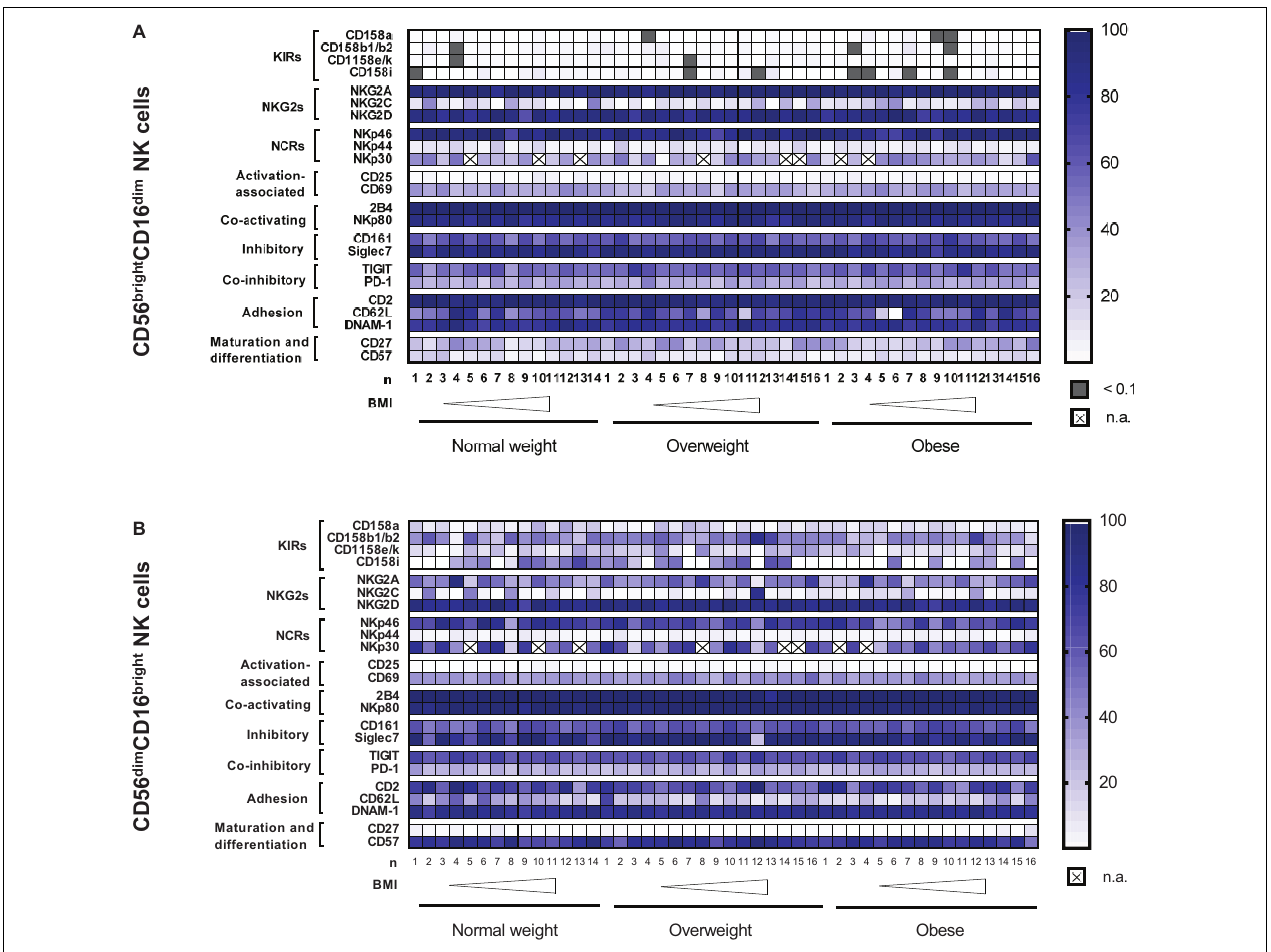
FIGURE 6 | Heatmaps showing the surface receptor expression on CD56 bright CD16 dim NK cells (A) and CD56 dim CD16 bright NK cells (B) as frequencies of total NK cells. Data were analyzed in peripheral blood mononuclear cells (PBMCs) isolated from normal weight ( n = 11–14), overweight ( n = 14–16) and obese ( n = 14–16) healthy blood donors. The donors are ordered by increasing body mass index (BMI) from left to right. CD, cluster of differentiation; BMI, body mass index; DNAM-1, DNAX accessory molecule 1; KIRs, killer-cell immunoglobulin-like receptors; n.a., not analyzed; NCRs, natural cytotoxicity receptors; NKG2s, natural killer group 2 receptors; TIGIT, T-cell immunoreceptor with Ig and ITIM